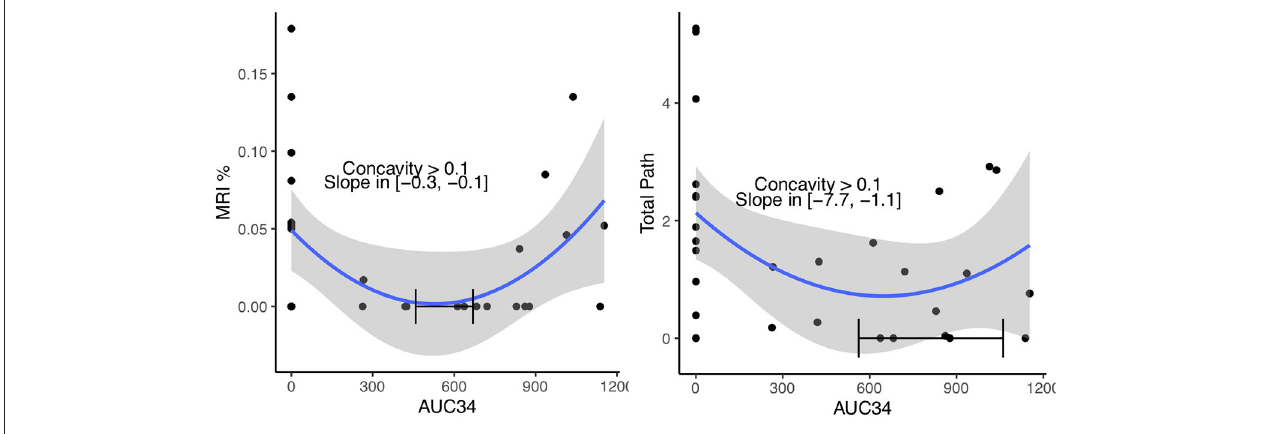
FIGURE 2 | Quadratic regressions of MRI and Total Path vs. AUC34. The relationship estimated using all 30 pigs and confidence region (blue line and gray band) is shown. A 95% confidence interval of the minimizing AUC34, lower 2.5% confidence bound on the concavity and the 95% confidence interval on the slope at AUC34 = 0 are shown on each plot.